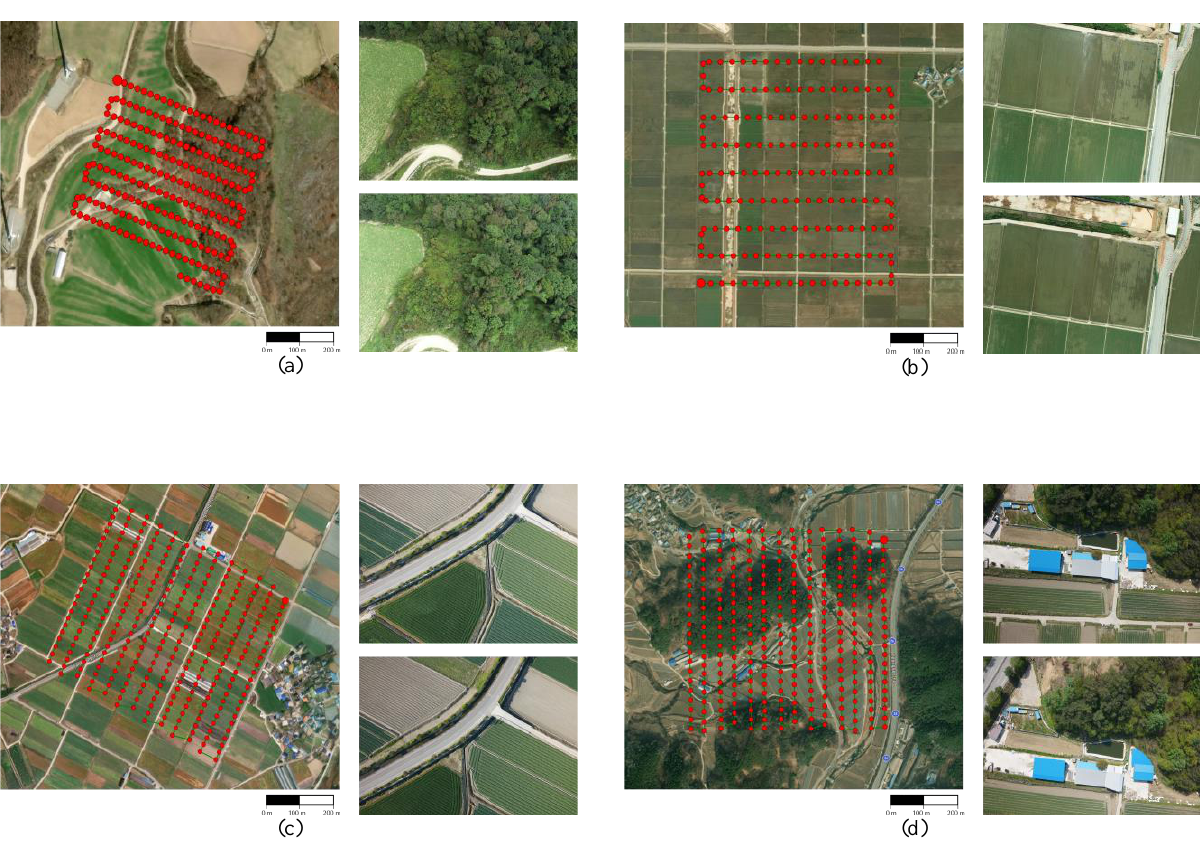
Figure 1. Flight trajectory and locations of acquired images